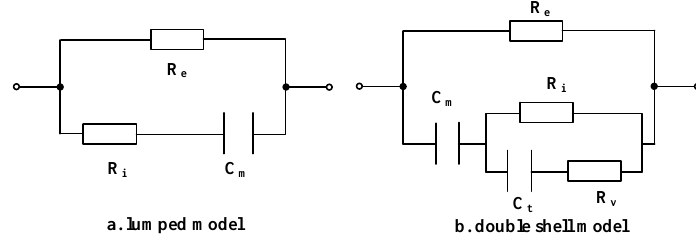
Figure 2. Bioelectrical impedance equivalent circuit model